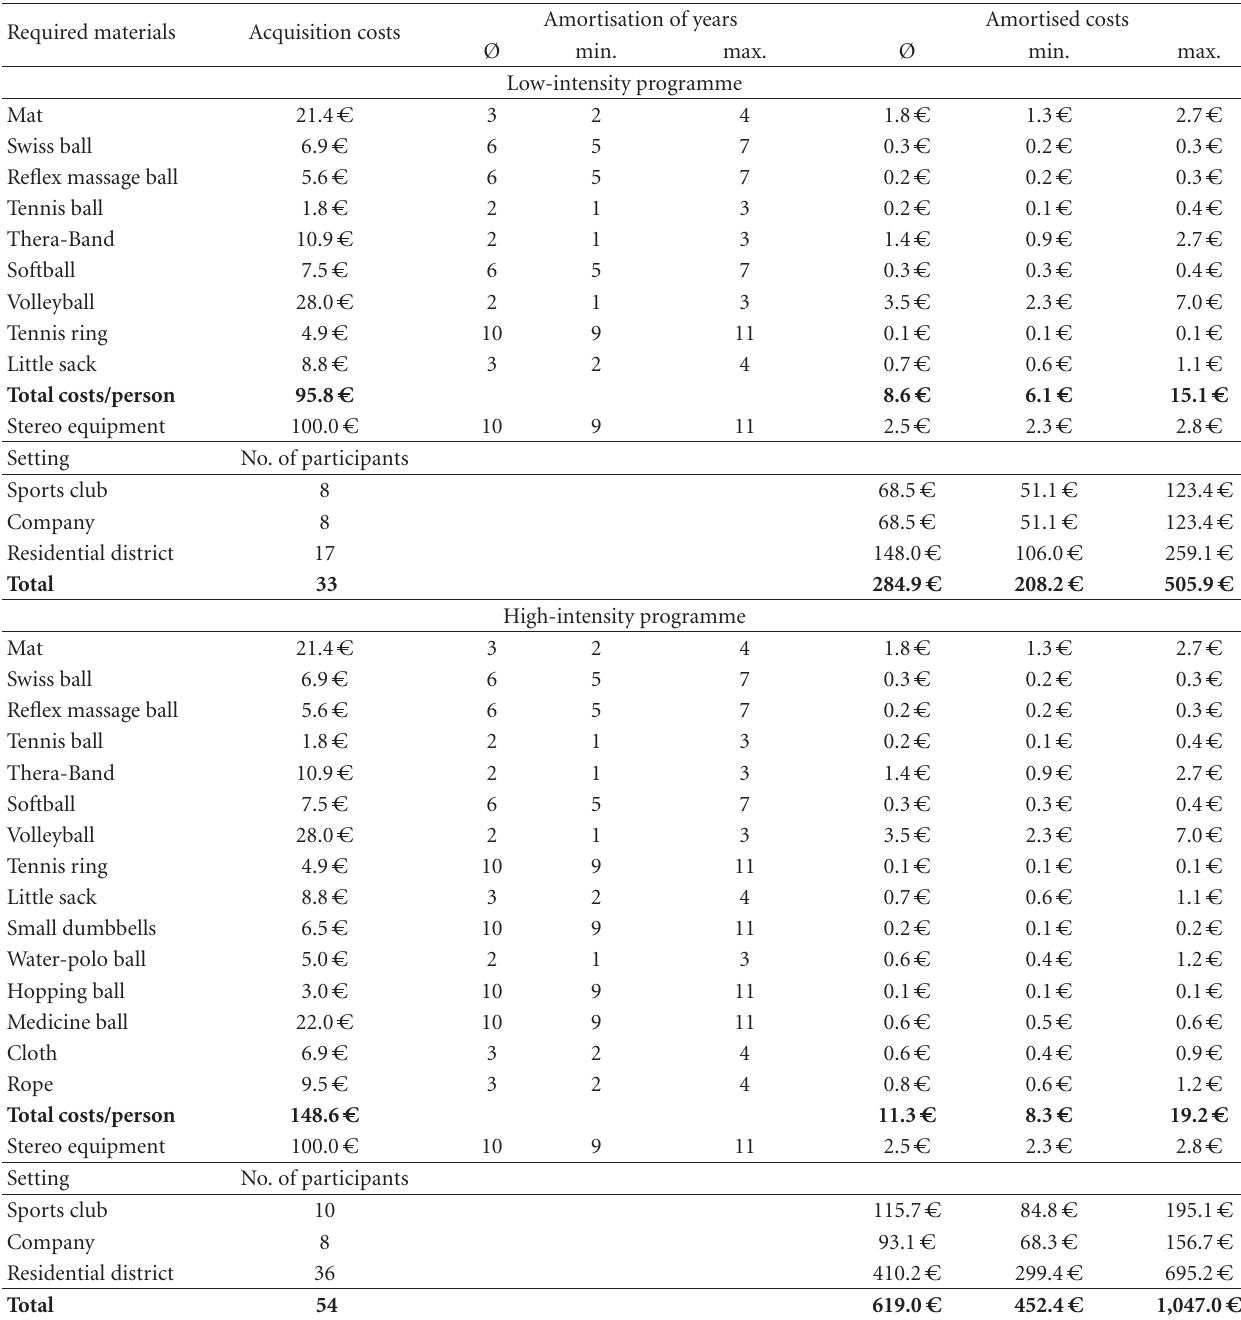
Table 3: Per capita and total imputed costs of equipment by type of equipment, type of programme, and duration of working life. Required